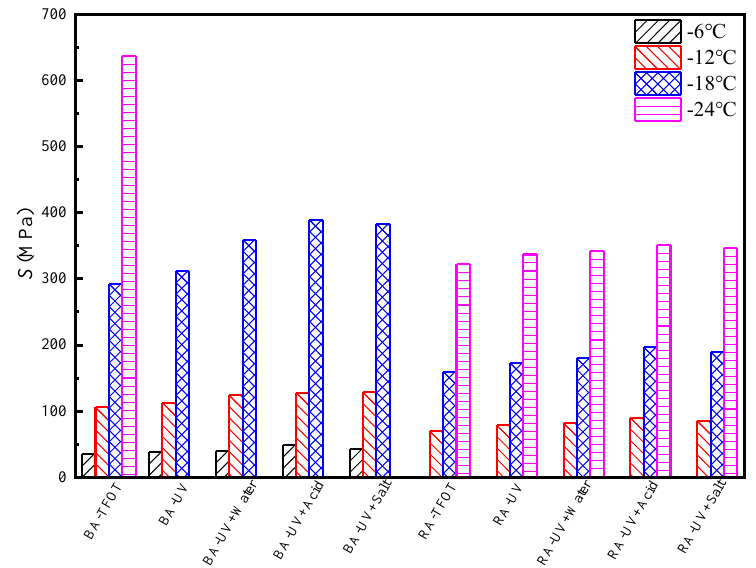
Figure 4. The stiffness modulus ( S ) of asphalt after UV aging under different environmental conditions.